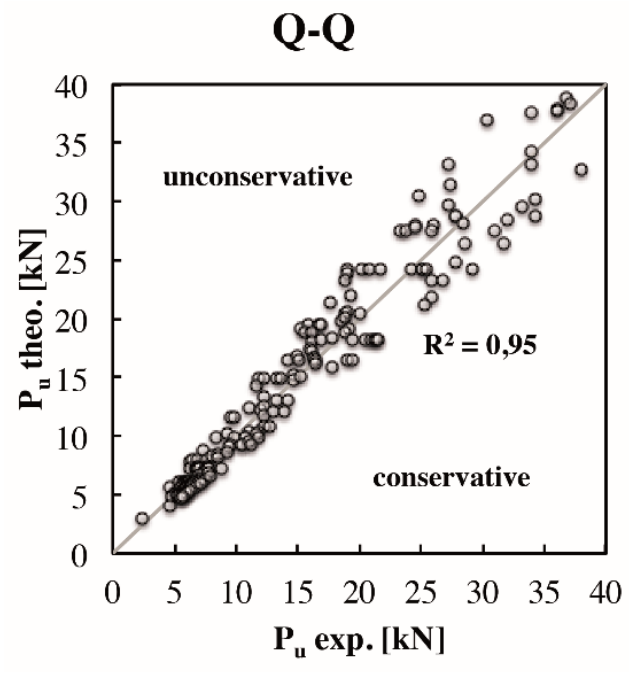
Figure 7. Experimental vs. theoretical correlation in the quartile–quartile range. The grey area illustrated in Figure 8 is indicative of the validity of the model. A good match of the actual and predicted value of the P u may be appreciated for the whole database. In particular, the specimens, with the worst forecast (i.e., larger scatter from the experimental relative result) are in the conservative side and represent the 15% of the whole population.